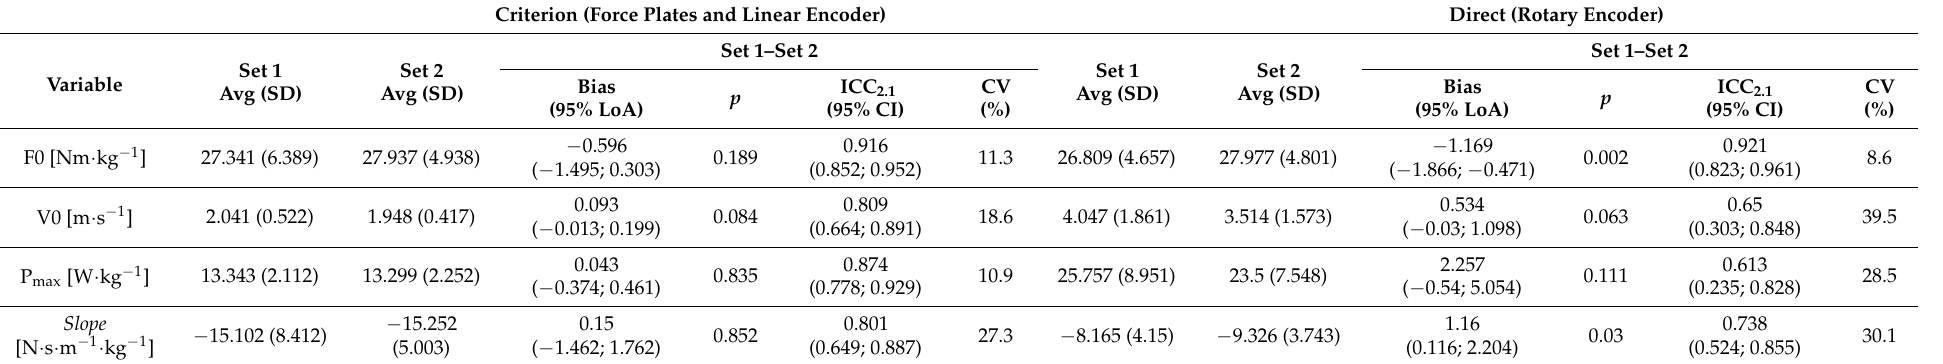
Table 2. Descriptive statistics and inter-set reliability of the observed mean force–velocity–power output variables.